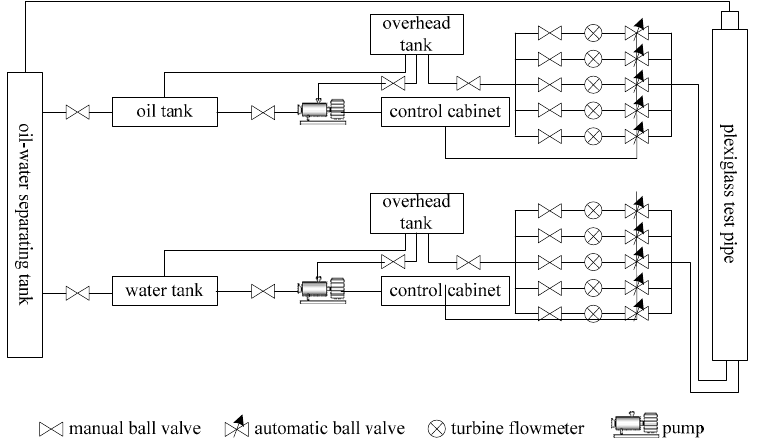
Figure 3. Schematic diagram of horizontal simulation well of Oil-water two-phase flow loop.